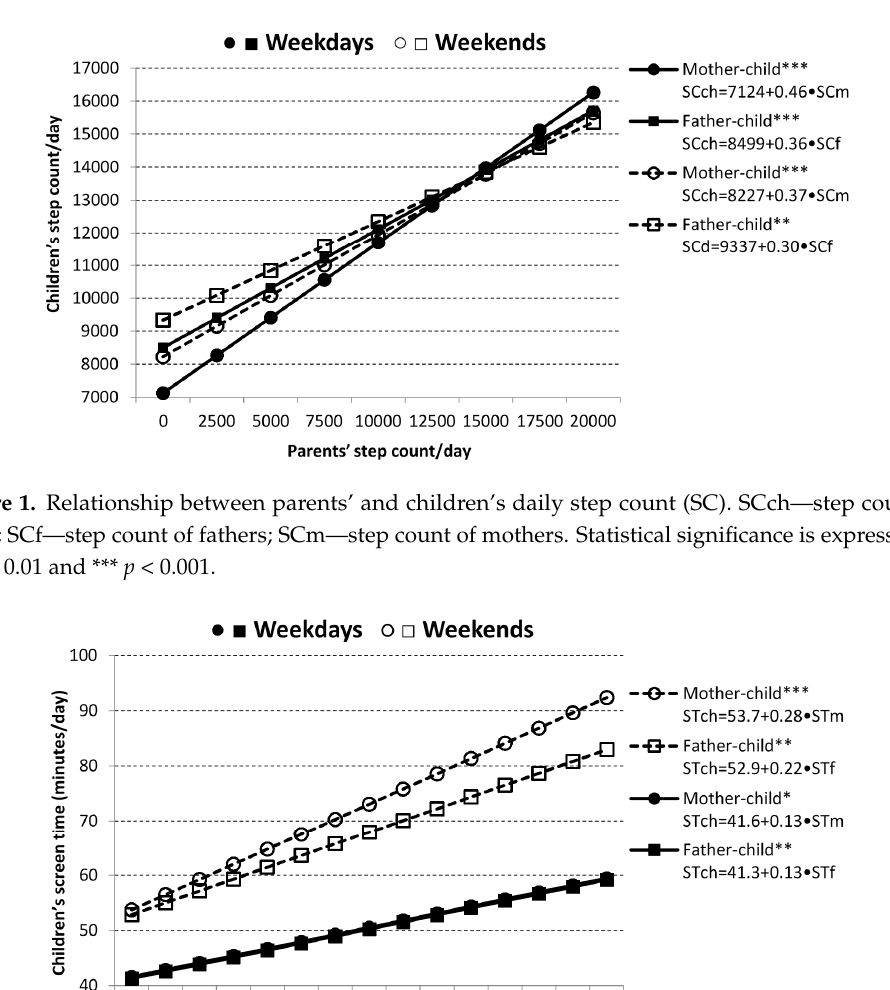
Figure 2. Relationship between parents’ and children’s daily screen time (ST). STch—screen time